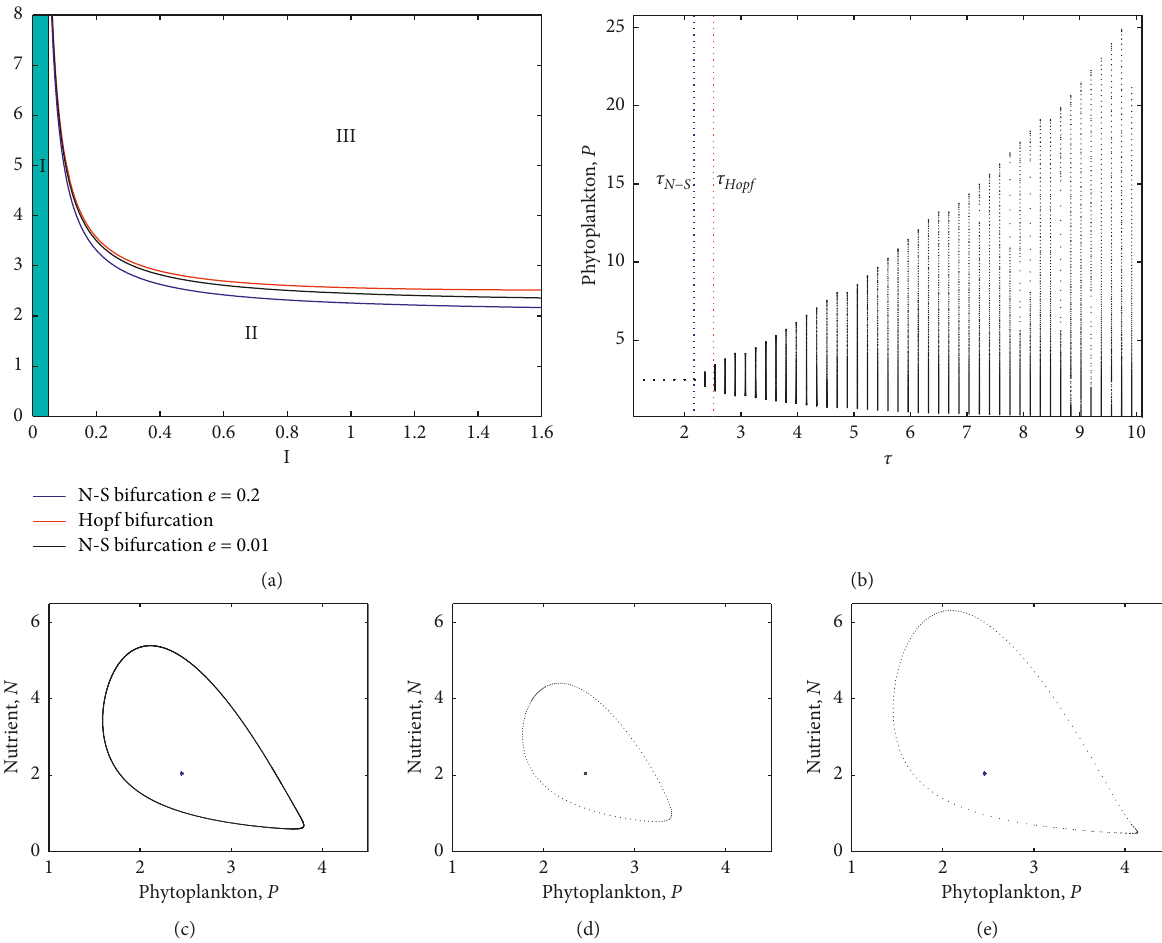
Figure 2: (a) Parameter space graph of Neimark–Sacker bifurcation and Hopf bifurcation with I and τ ; (b) bifurcation diagram of Neimark–Sacker bifurcation with τ and phytoplankton; (c–e) phase portraits of Neimark–Sacker bifurcation with parameters (c) e � 0 . 01, τ � 3; (d) e � 0 . 2, τ � 2 . 45; (e) e � 0 . 2, τ � 3. Other parameter values: I � 1 . 6, a � 0 . 5, b � 0 . 8, α � 0 . 7, m � 0 . 45, q � 0 . 01, and ε � 0 . 001. ∗ Asymptotically stable fixed point E ∗